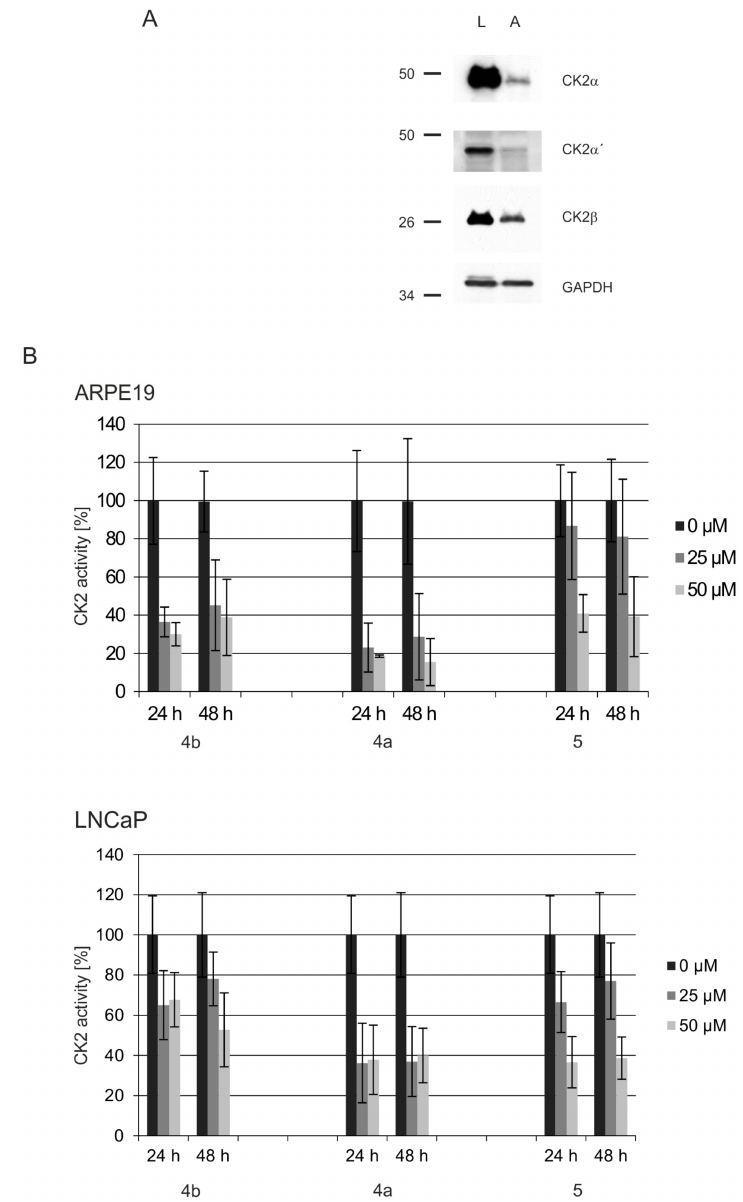
Figure 4. Expression of CK2 in prostate cancer cell line LNCaP and non-neoplastic retinal pigment epithelial cell line ARPE19 and inhibition of intracellular activity by dibenzofurans. ( A ) Cells were extracted with RIPA buffer. 50 µ g cell extract was separated on a 12.5% SDS polyacrylamide gel and transferred to a PVDF membrane followed by Western blotting with anti-CK2 α (1A5), anti-CK2 α ’ (#30), anti-CK2 α (6D5) and anti-GAPDH antibodies. GAPDH was used as a loading control. ( B ) ARPE19 or LNCaP cells were treated with DMSO as control (0 µ M) or with 25 or 50 µ M 4b , 4a or 5 for 24 or 48 h. Kinase activity of CK2 in the cell extracts was measured with the synthetic CK2 specific peptide substrate, RRRDDDSDDD, in the presence of [[ 32 P] γ ATP. Results from at least three individual experiments are shown; the activity in the control cells was set to